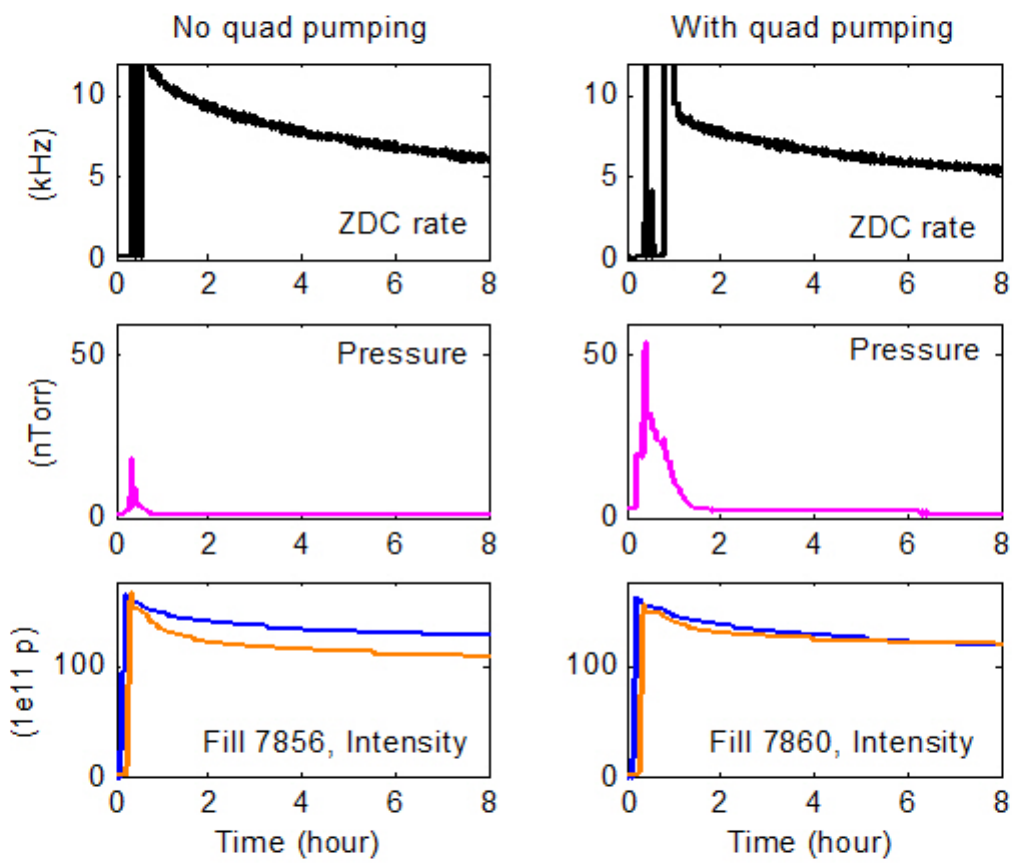
FIG. 14. (Color) Event rates from collisions, sum of pressure in 4 warm locations, and beam intensity for two stores. The left column shows the standard situation, the right column shows a store for which shorter bunches were injected from the AGS